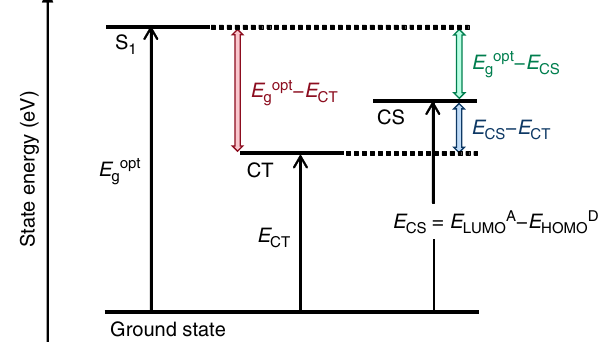
Fig. 1 Schematic of the state energy. E g opt , E CT , and E CS are the energy of singlet excited state, charge transfer state and charge-separated state, respectively. E CS was determined by the energetic difference between the onset energy of the lowest unoccupied molecular orbital band for the acceptor and that of the highest occupied molecular orbital band for the